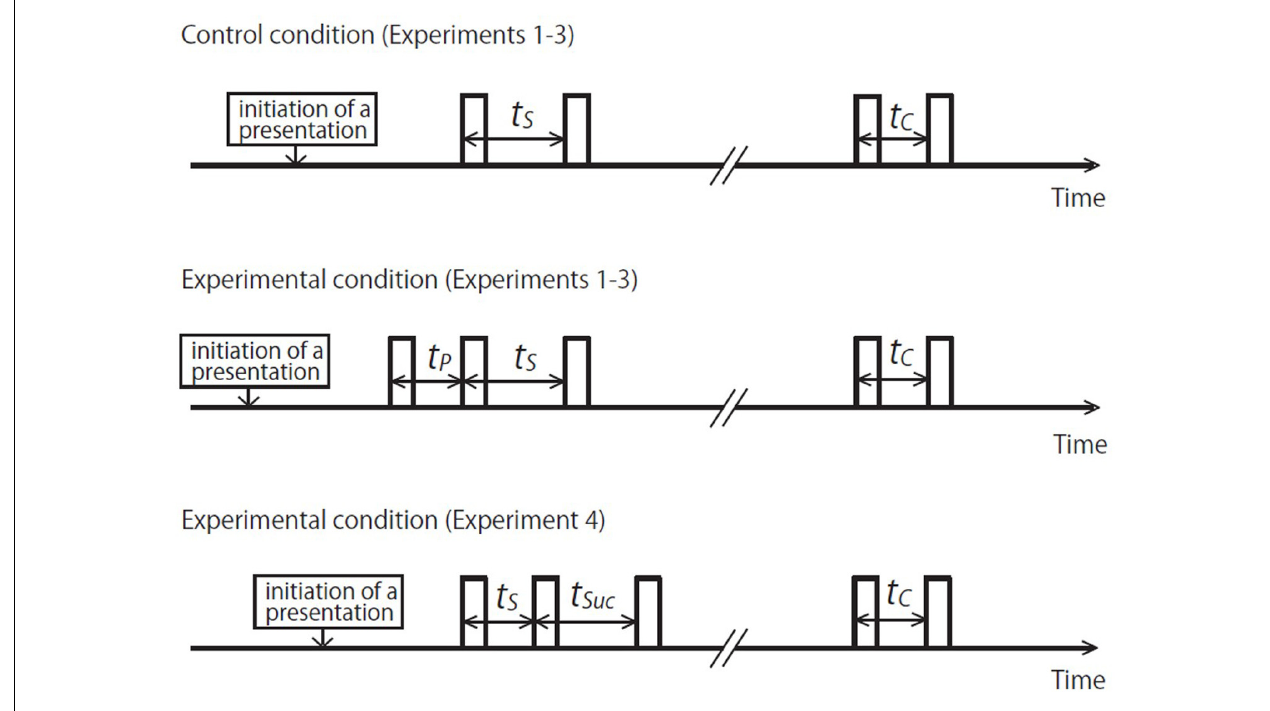
FIGURE 1 |Time charts of stimulus patterns. The rectangles represent sounds. In the experiments, participants adjusted t C to make its subjective duration equal to that of t S . In the experimental conditions of Experiments